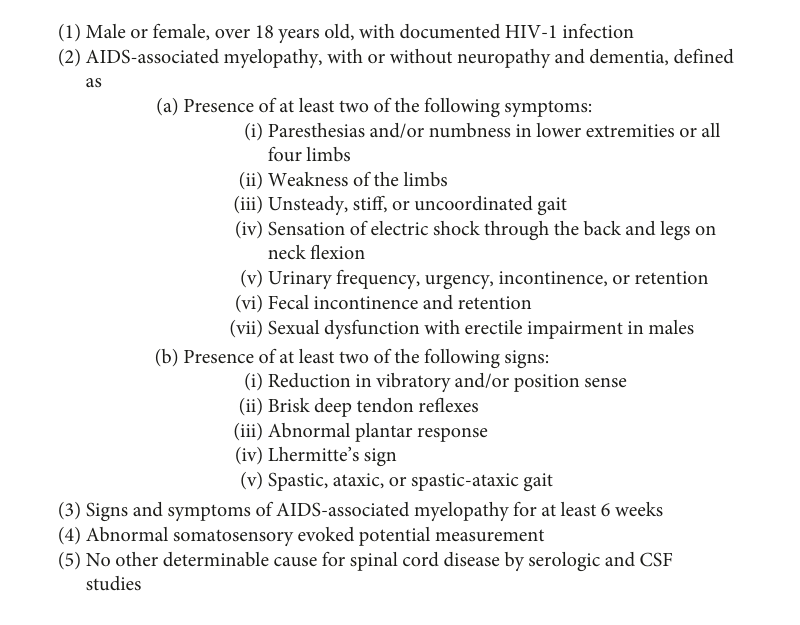
Figure 1: Criteria for clinical diagnosis of AIDS-associated myelopathy